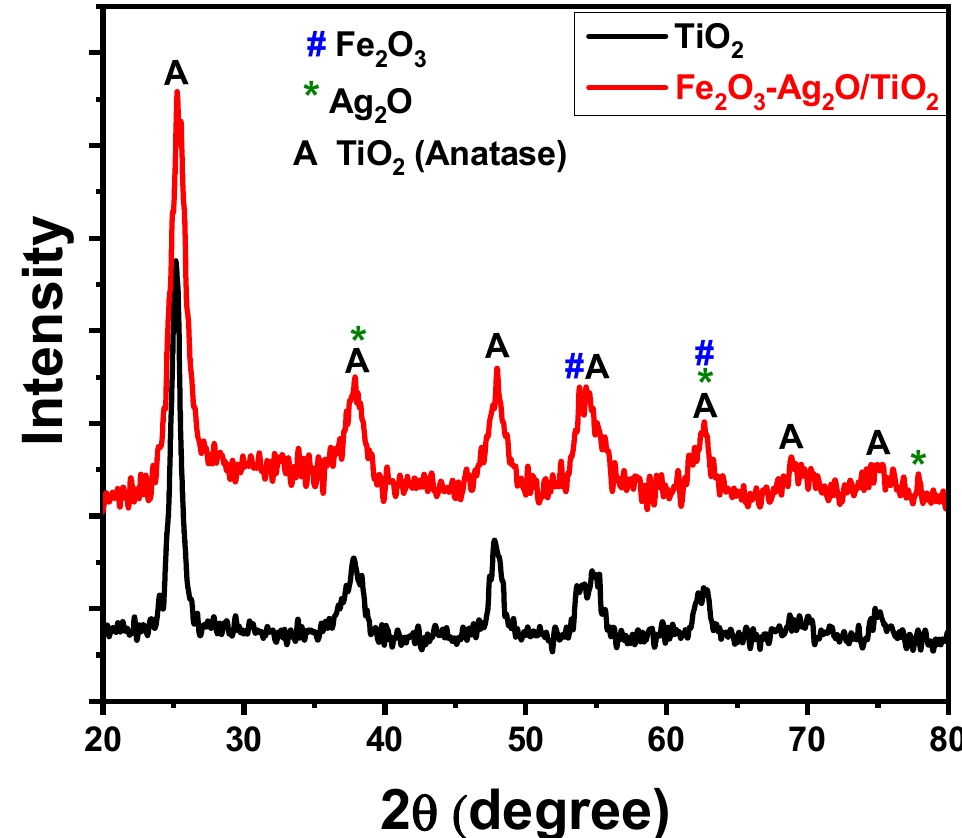
Figure 3. XRD patterns of pure TiO 2 and Fe 2 O 3 -Ag 2 O/TiO 2 nanocatalyst.